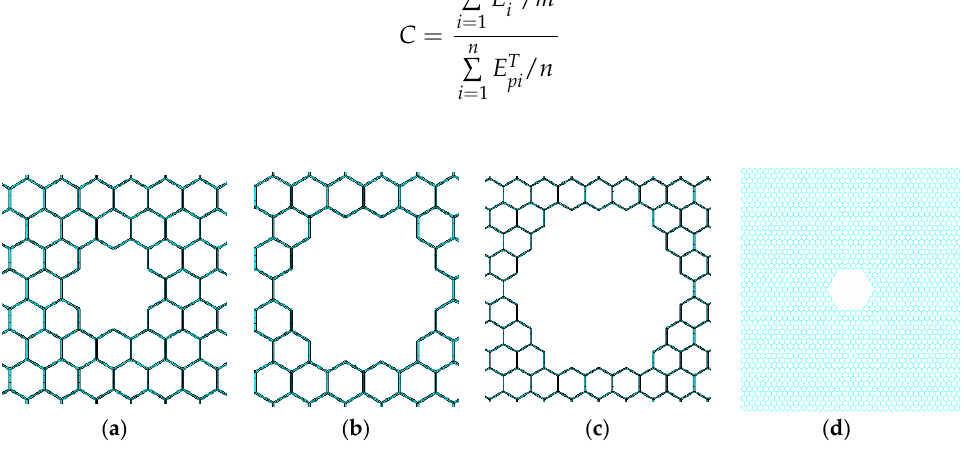
Figure 5. Center concentrated vacancy defects. The size of center concentrated vacancy defects is gradually amplified from ( a – d ).